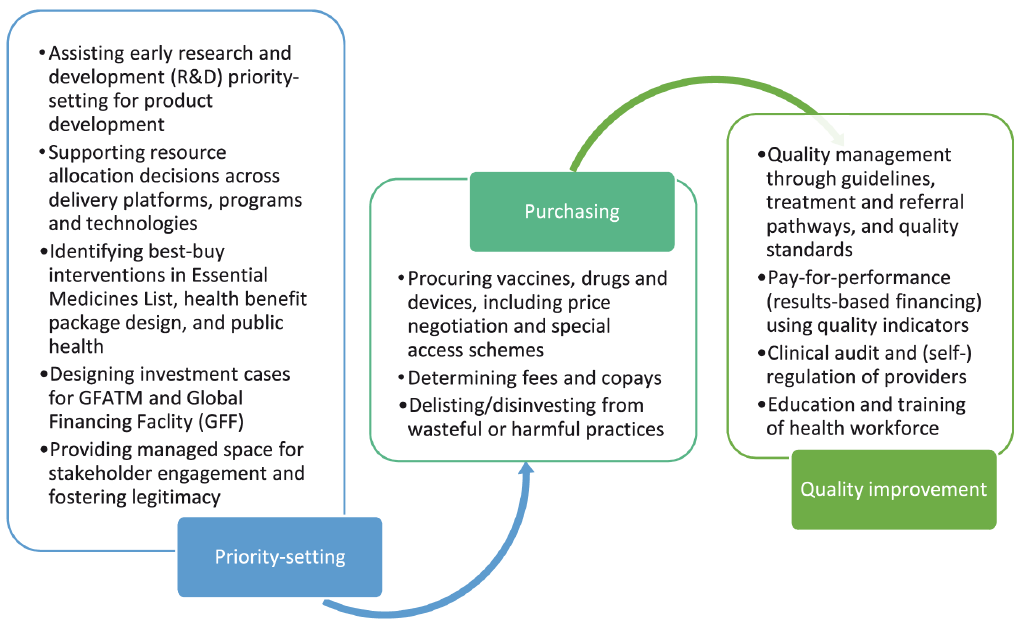
Figure 1. How health technology assessment (HTA) can be used to inform resource allocation and purchasing of health services